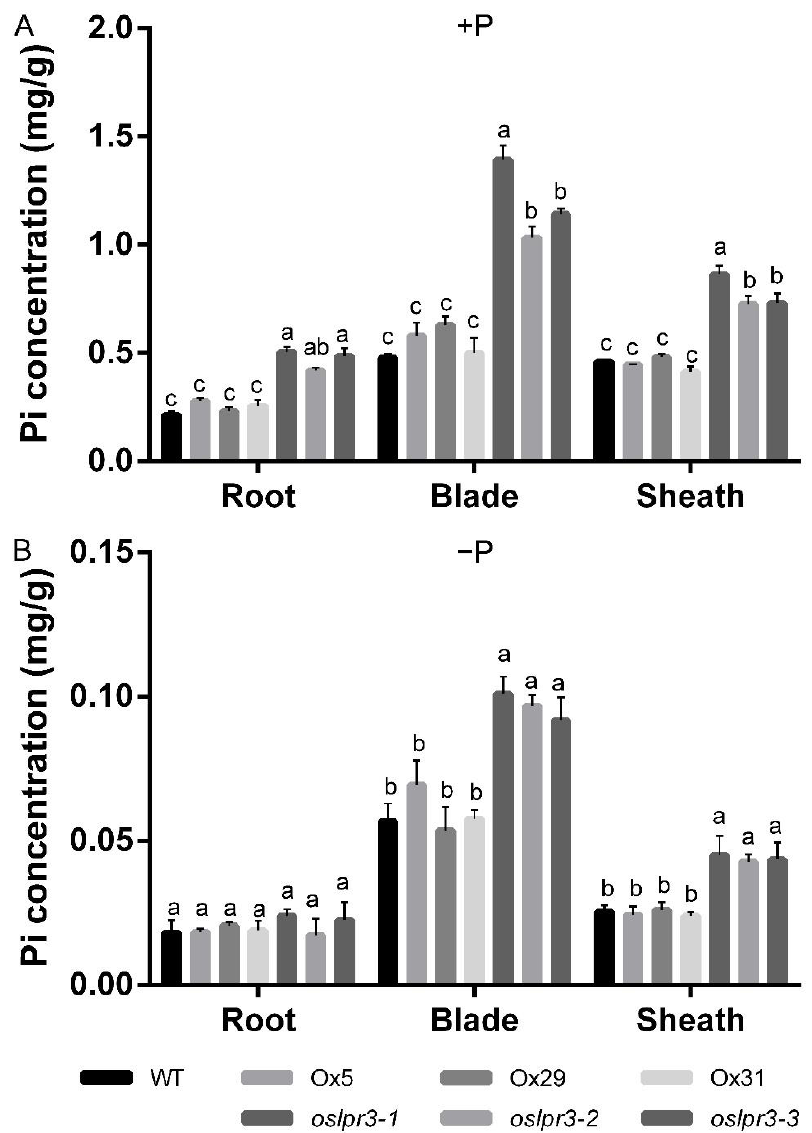
Figure 6. Pi concentration in OsLPR3 -Ox and oslpr3 lines. Seedlings (10-d-old) of WT, OsLPR3 -Ox, and oslpr3 lines were grown hydroponically under +P ( A ) and − P ( B ) conditions for 21 d. The Pi concentration was determined in roots, leaf blades, and leaf sheaths. Values are means ± SE ( n = 5). Different letters above the bars indicate significant differences ( P < 0.05, one-way ANOVA).